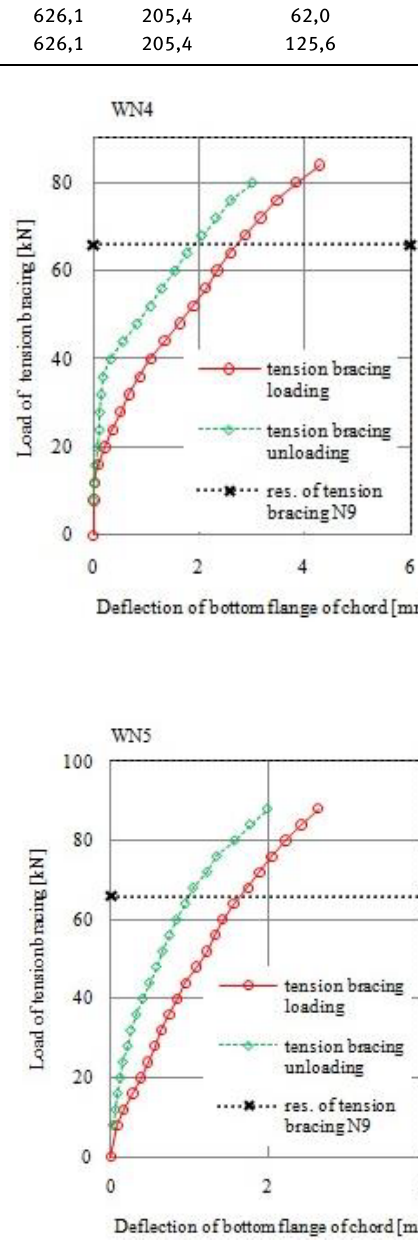
Figure 9: Load-deflection diagram for joint WN5 ( β =